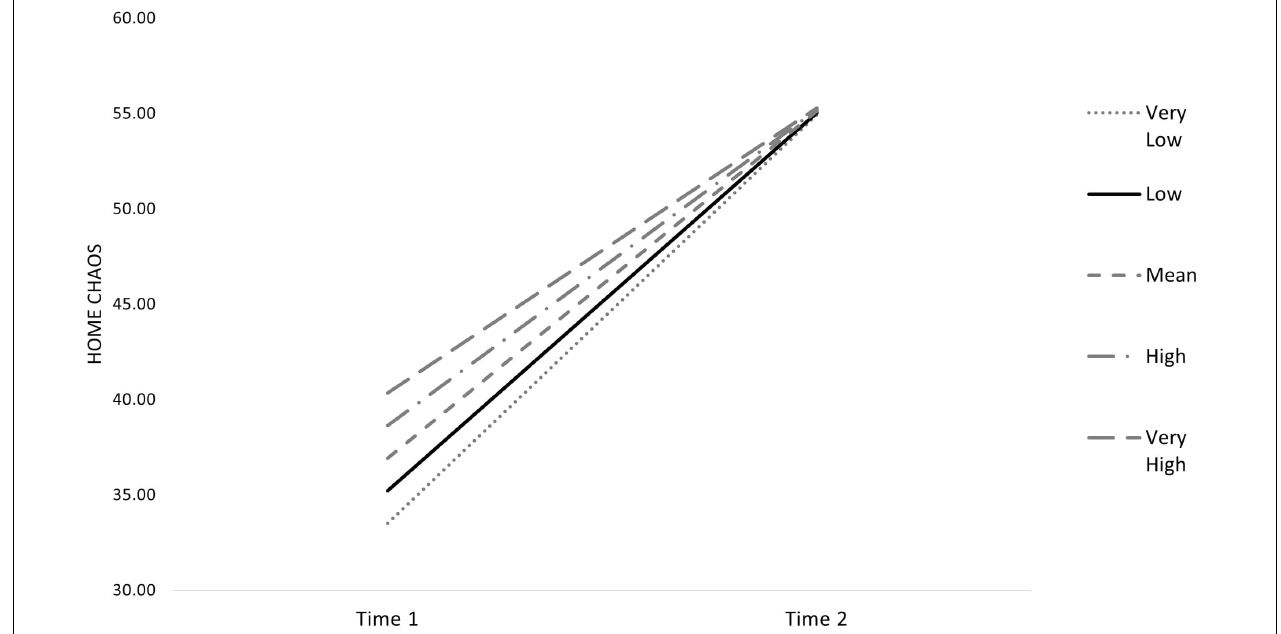
FIGURE 3 | Changes in home chaos according to parental negative control.